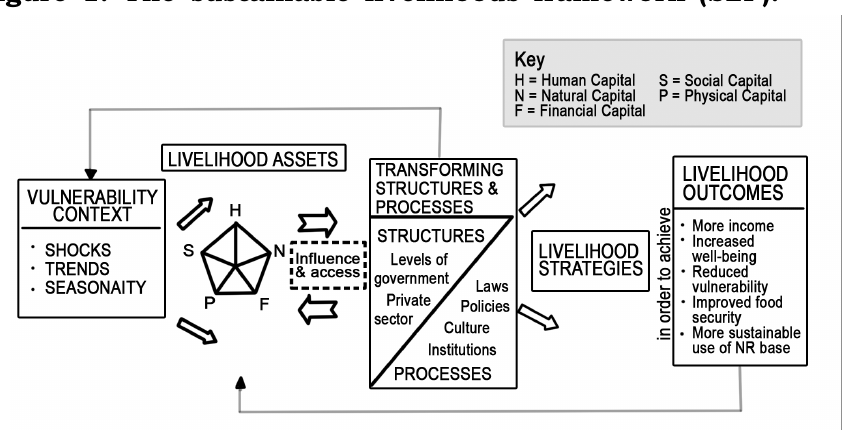
Figure 1: The sustainable livelihoods framework (SLF).